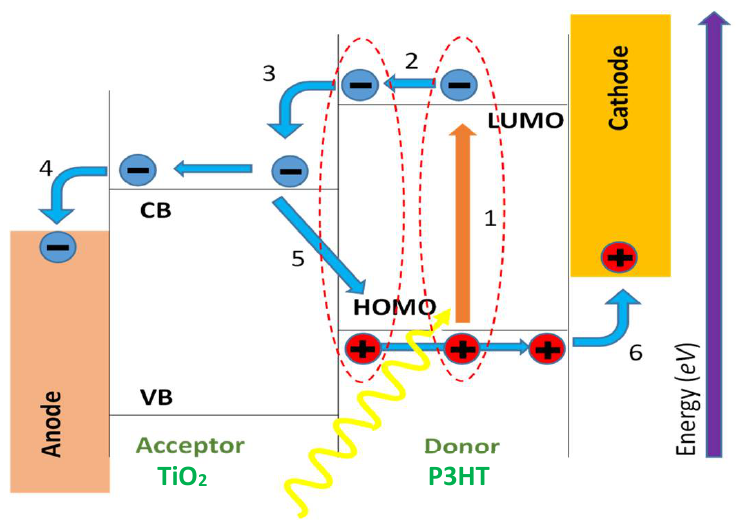
Figure 1. Principle process in hybrid metal oxide/polymer solar cell in an energy level diagram under short circuit conditions [39,61]. The step numbers represent as (1) light absorption ( η a ) and Exciton creation ( η ex ), (2) diffusion of the exciton to the interface between the metal oxide and polymer ( η dif f ), (3) electron-hole pair dissociation into free charge carriers ( η ed ), (4) charge transport ( η tr ), (5) recombination of charge and (6) charge collection ( η cc ).